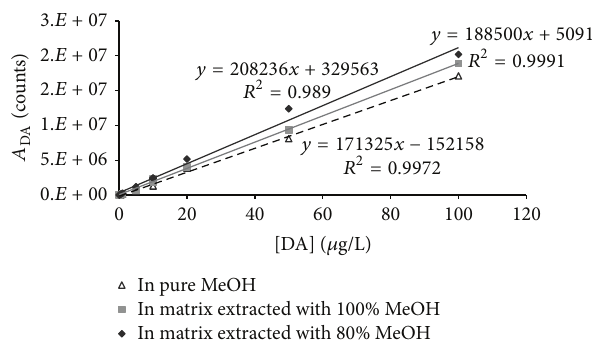
Figure 3: A qualitative evaluation of matrix effects in the method for the determination of DA in mussel tissue using two different extraction solvents, methanol/water 80: 20 and methanol.